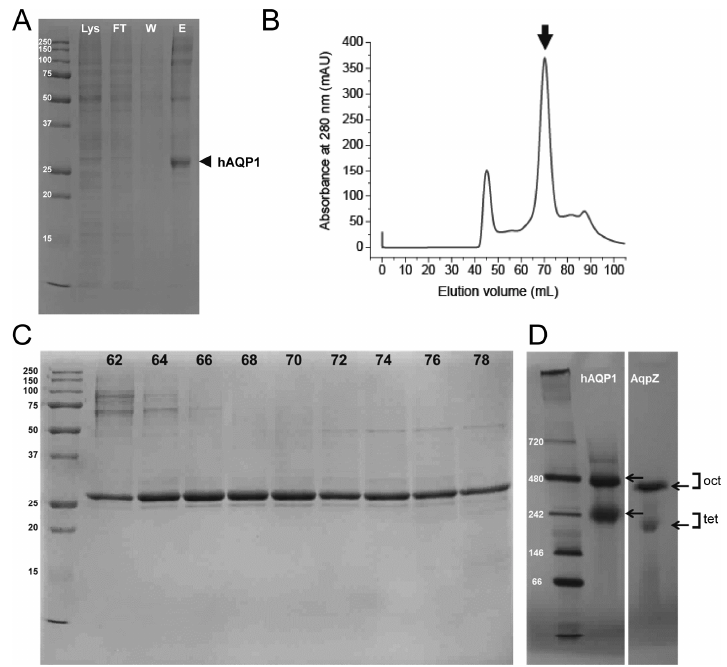
Figure 1. Purification and oligomeric status of human aquaporin 1 (hAQP1). ( A ) fraction analysis of Ni-NTA purification profile in SDS-PAGE of hAQP1 from Sf9 cells: Lys, whole cell lysate; FT, flow-through; W, wash; E, eluent. The arrow points to the purified hAQP1 monomer at ~31 kDa; ( B ) gel filtration profile of hAQP1 purification. The major peak eluted at 70 mL (arrow) and corresponds to the tetrameric hAQP1 (~124 kDa). The minor peak at 45 mL (void volume, V 0 ) contained aggregates of hAQP1; ( C ) SDS-PAGE of the fractions from 62 to 78 mL eluted in the gel filtration chromatography. The protein amount loaded per lane was 5 µg; and ( D ) Blue Native PAGE (BN-PAGE) of purified hAQP1 in 100 mM n -octyl- β - D -glucopyranoside (OG) and purified AqpZ as an internal control. The hAQP1 band at ~242 kDa corresponds to tetramers (tet, expected 124 kDa) and band at ~480 kDa corresponds to its octamer (oct, expected 248 kDa).